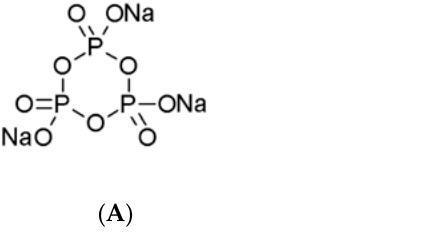
Figure 6. Chemical structures of STMP ( A ) and GA ( B ).